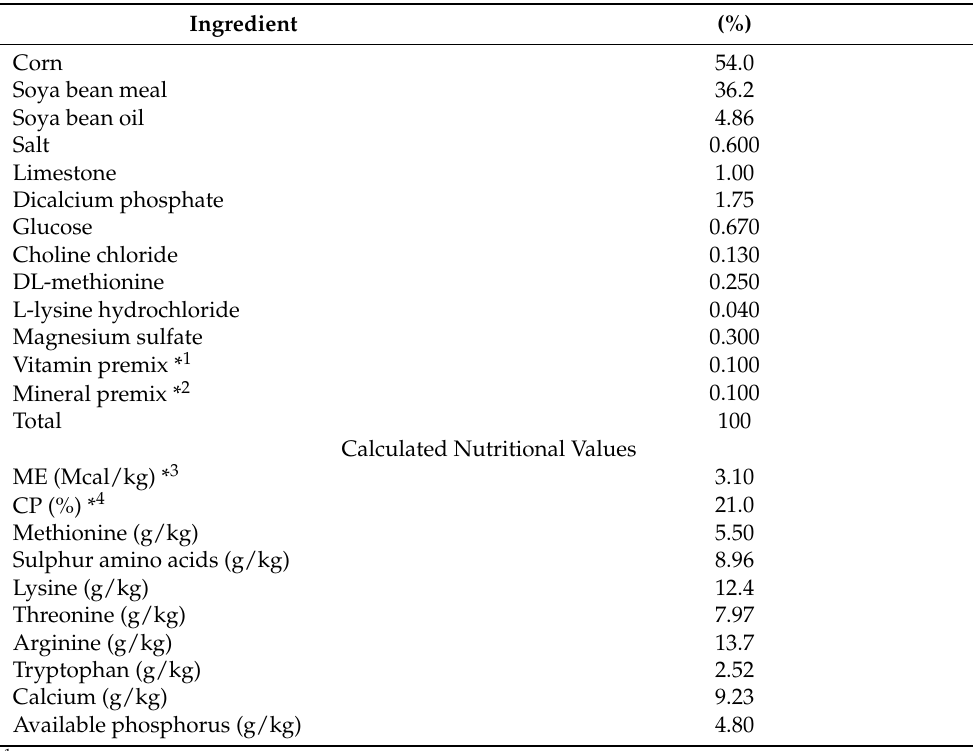
Table 1. Composition of the experimental